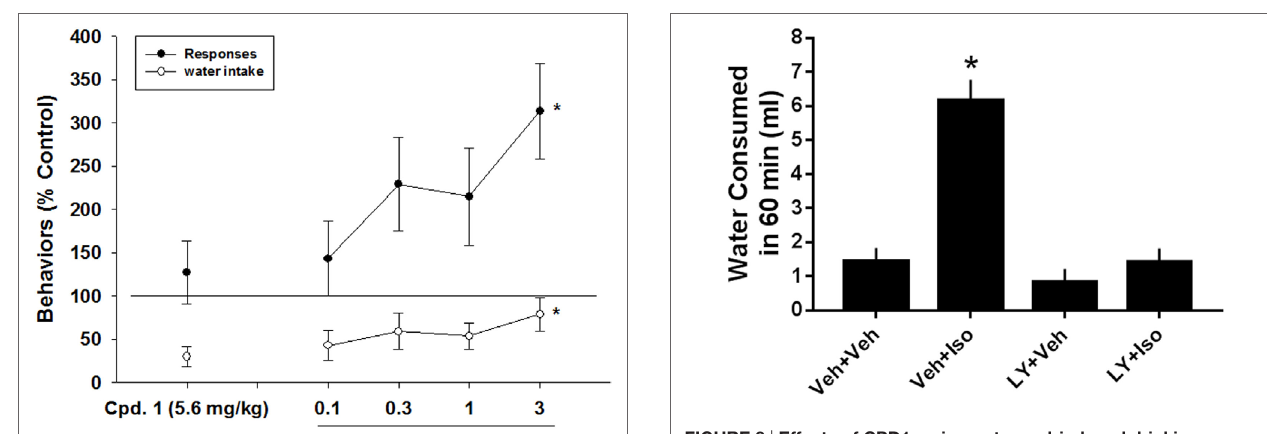
FigUre 8 | effects of cPD1 on isoproterenol-induced drinking . Isoproterenol significantly increased the amount of water consumed and this enhancement was prevented by 5.6 mg/kg CPD 1 ( F 3,48 = 24.9, p < 0.0001) that did not significantly affect normal drinking (LY + Veh). Data are means ± TaBle 4 | effects of the 5-hT 2c agonists cPD 1 and ro 60-0175 compared fluoxetine and pentobarbital on marble-burying, nestlet shredding, rotarod performance, and locomotor activity of mice. compound Marble- nestlet- rotarod locomotor burying shredding activity Fluoxetine